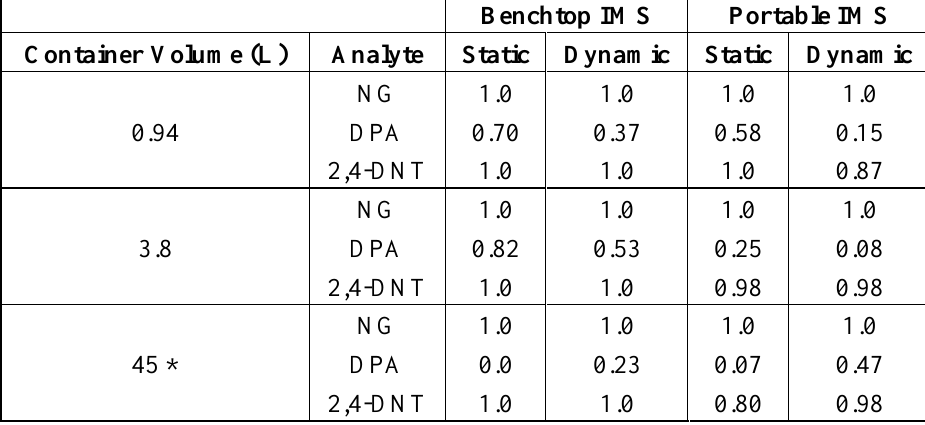
Table 4. True positive rates for smokeless powders in different containers (1–45 L) for bench top and portable IMS systems with 60 replicates.